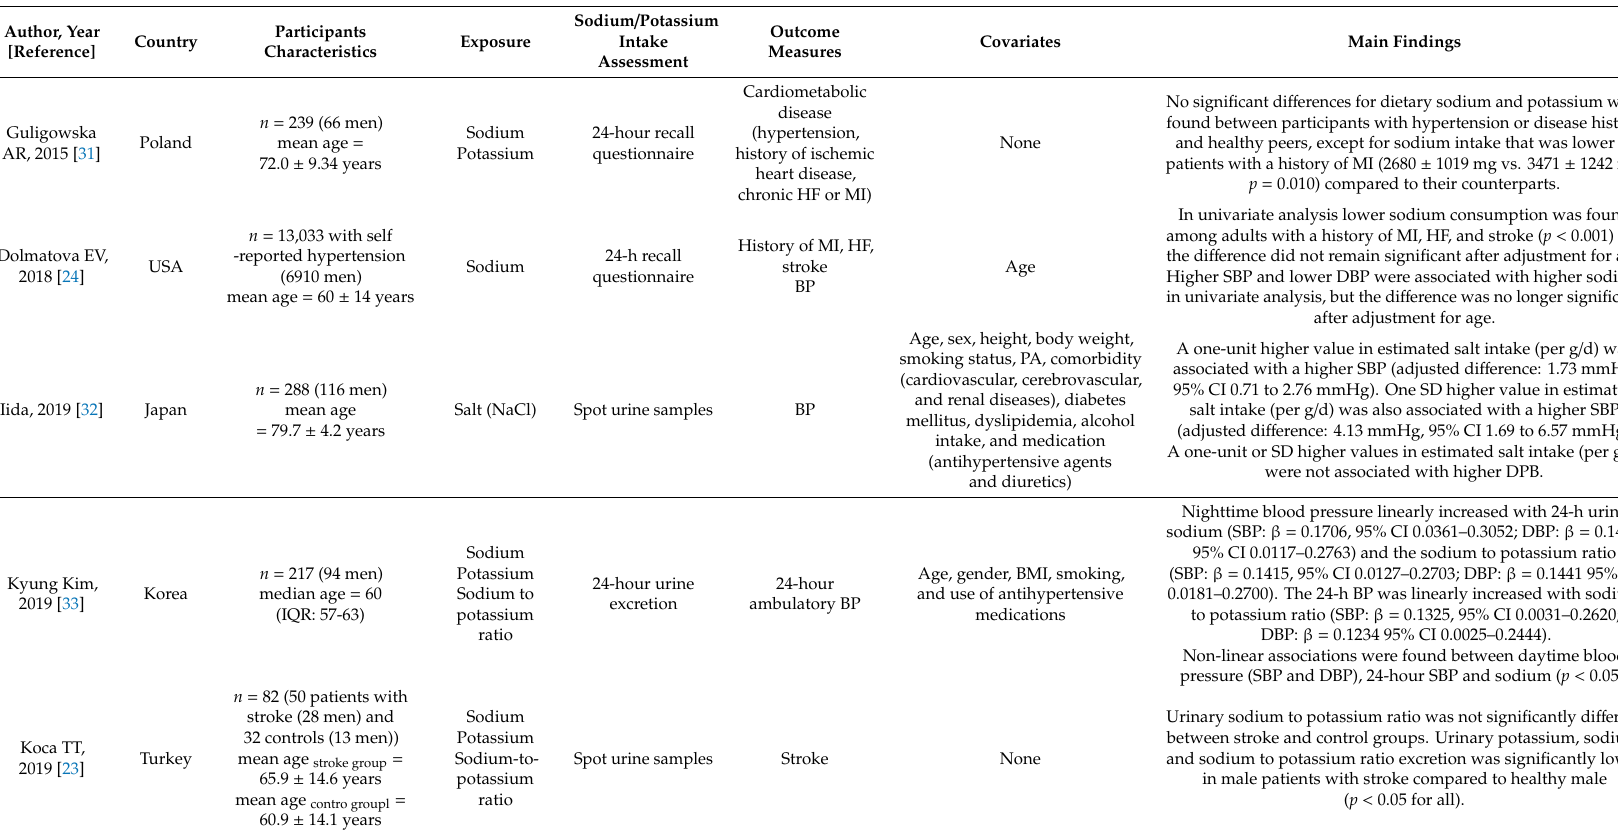
Table 1. Characteristics of included cross-sectional studies in systematic review of dietary sodium, potassium, sodium-to-potassium ratio, and cardiovascular